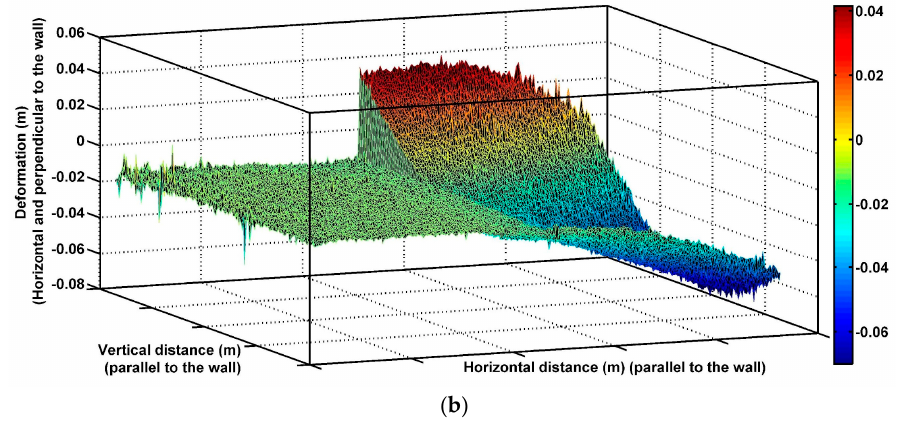
Figure 4. 3D Illustration of retaining wall displacement contours (with color scale) in m for ( a ) Scenario J and ( b ) Scenario L.